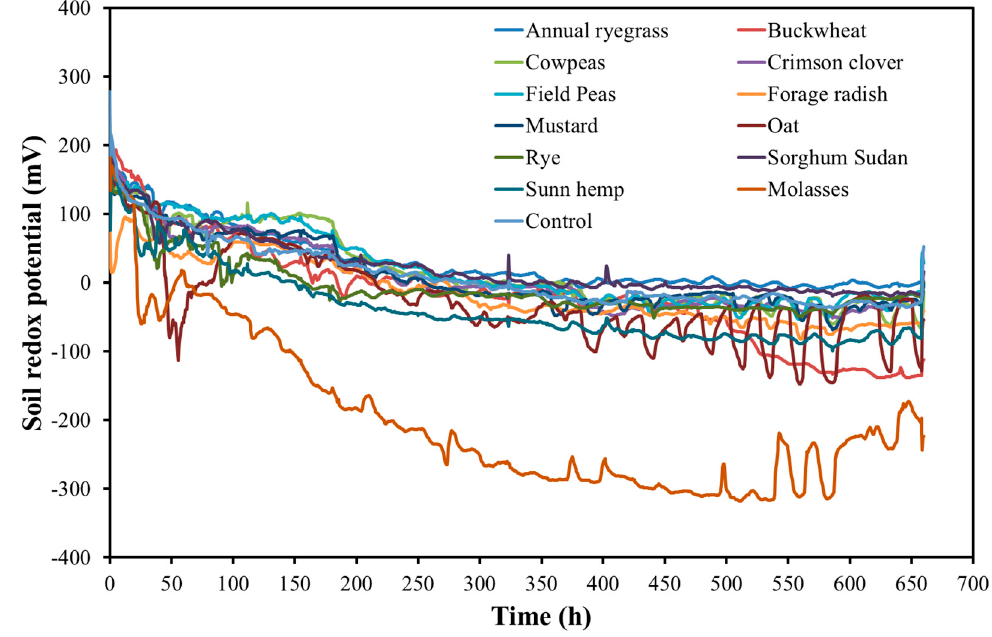
Figure 1. Soil redox potential time course over 28 days after treatment application.